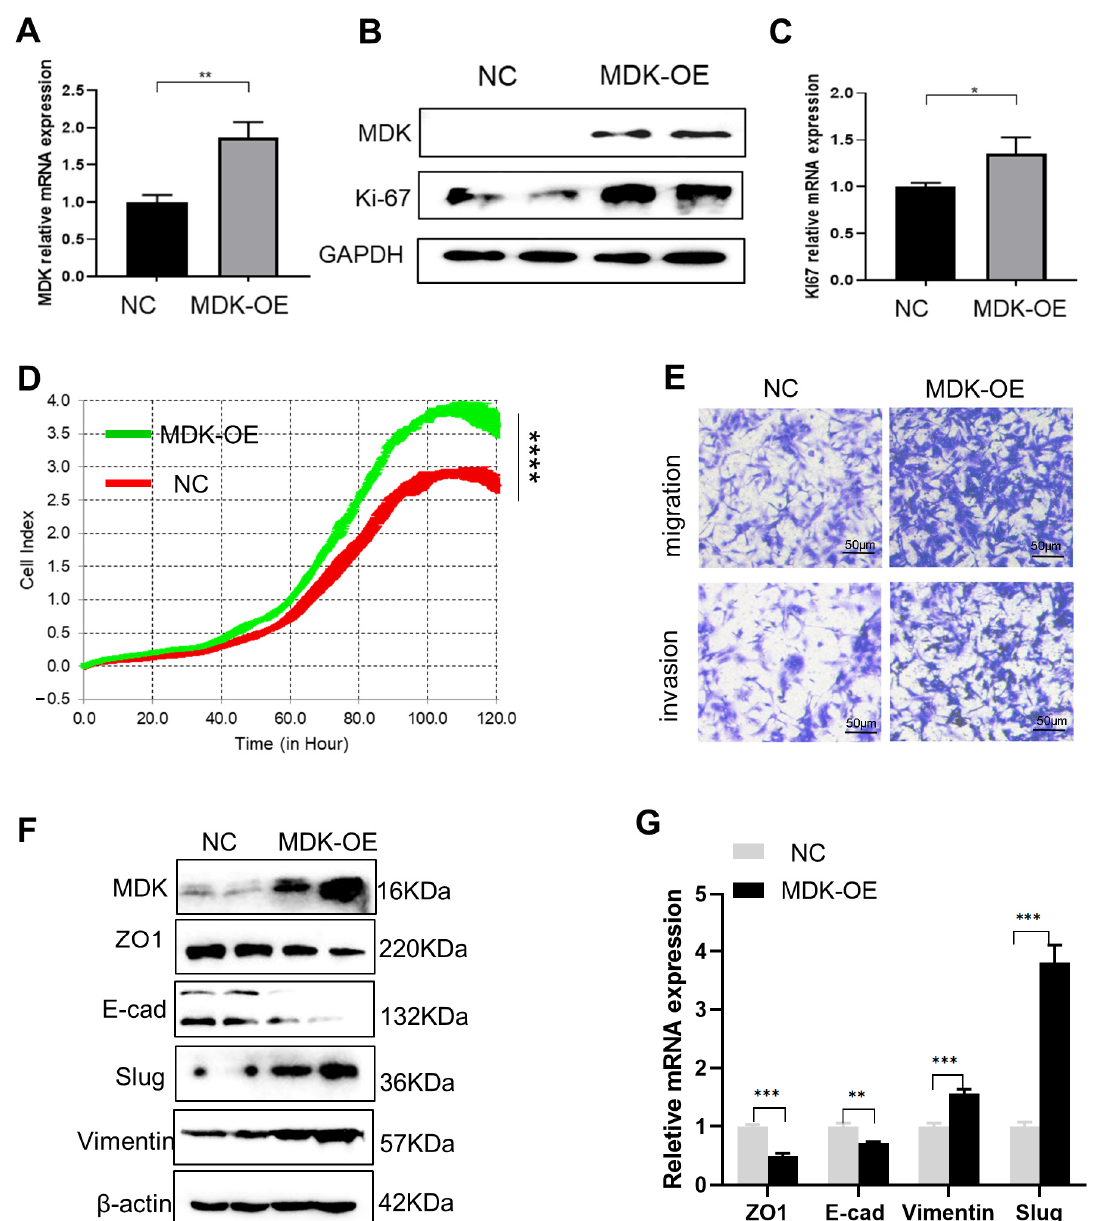
Figure 3. MDK promotes cell proliferation, migration, and invasion in SKOV3 cells. ( A ) Real-time qPCR validation of MDK overexpression in SKOV3 cells. ( B ) Western blotting assays to examine the effect of MDK overexpression on the expression of cell proliferation marker Ki67 in SKOV3 cells. ( C ) Real-time qPCR assays to examine the effect of MDK overexpression on the expression of Ki67 in SKOV3 cells. ( D ) RTCA determination of the effect of MDK overexpression (OE) on the cell pro- liferation of SKOV3 cells. ( E ) Transwell assays to evaluate the effect of MDK overexpression on the migration and invasion properties of SKOV3 cells. ( F ) Western blotting assays to examine the influ- ence of MDK overexpression on the expression of EMT markers. ( G ) Real-time qPCR validation of the influence of MDK overexpression on the expression of EMT markers. Data are represented as mean ± SD, n = 3. * p < 0.05, ** p < 0.01, *** p < 0.001, **** p < 0.0001. NC, negative control; OE, over- expression. 3.4. MDK Inhibition Potentiates the Tumoricidal Effect of IFN- γ in SKOV3 Cells To assess whether targeting MDK would augment the anti-tumor activity of IFN- γ in ovarian cancer, we treated the SKOV3 cells with a potent MDK inhibitor, iMDK, and then evaluated the effect of MDK inhibition on the tumoricidal activity of IFN- γ . Though high-dose IFN- γ exerts anti-proliferation function, CCK8 analysis showed that a 48 h treatment with IFN- γ alone caused a only 29.6% inhibition rate at a 5000 ng/mL dose, and only a 34.4% inhibition rate, even at a dose as high as 10,000 ng/mL (Figure 4A); strikingly, combined usage of iMDK at 6.6 nM, a low dose resulting in no obvious cell death when